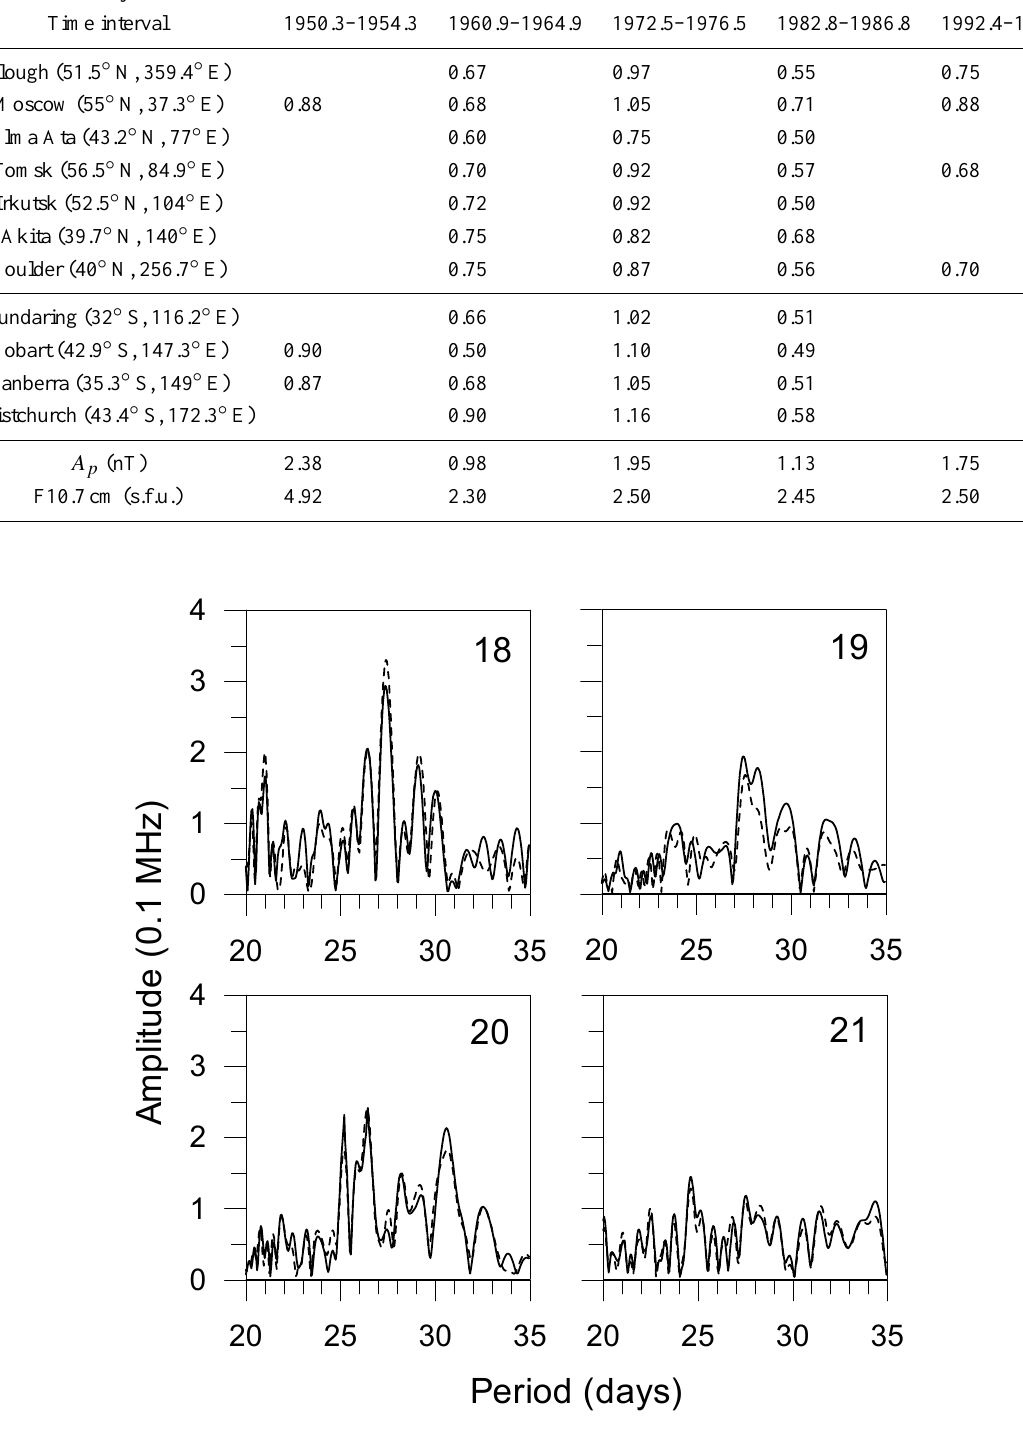
Fig. 4. The same as Fig. 2, but for fo F2 from Canberra for solar cycles